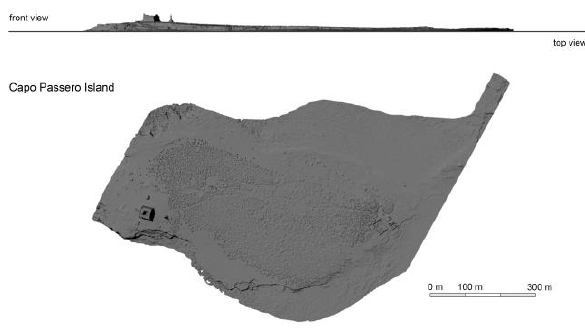
Figure 7. Polygonal topographical model of Capo Passero Island.